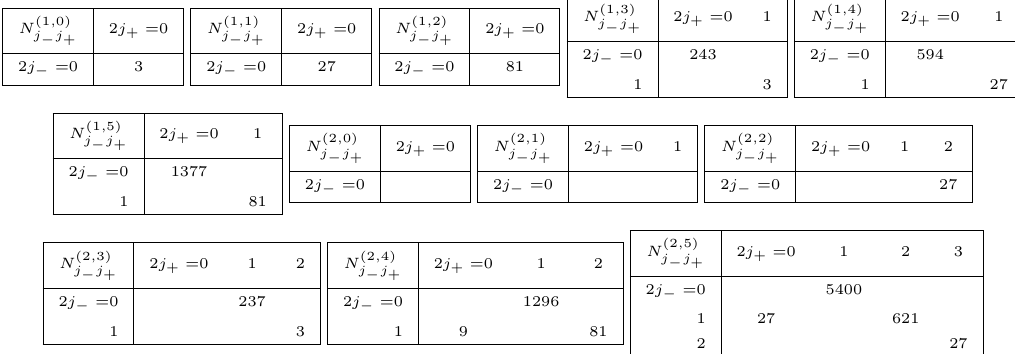
of M 0 , for base degree b (cid:20) 2 and (cid:12)ber degree d (cid:20) 5. 3 j (cid:0) ;j +